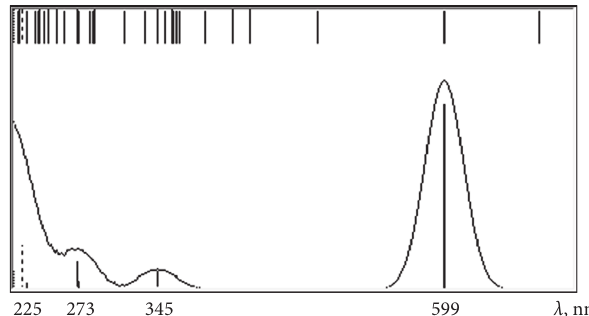
Figure 2: The absorption spectrum of PMD-I. It is calculated using the AM1 method considering the CI 12 × 12. All singlet and triplet quantum transitions (except the first one) are noted at the top without taking into account the oscillator